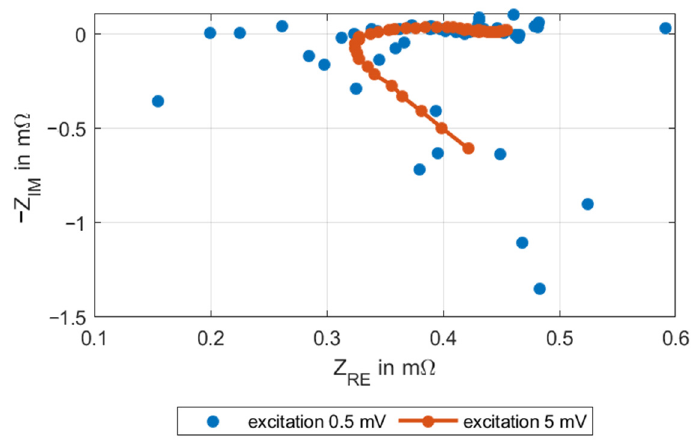
Figure 5. Excitation dependency for EIS measurements tested with a single test cell (64 Ah).